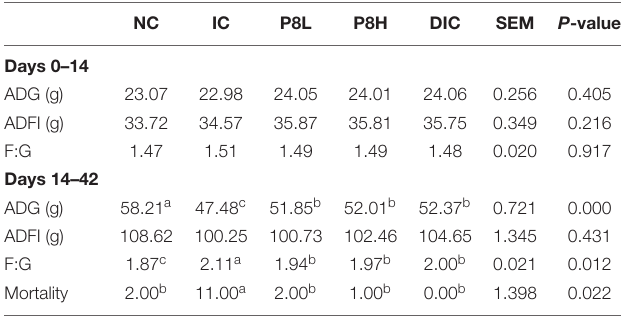
TABLE 3 | Effects of P8 on the growth performance of Eimeria -infected